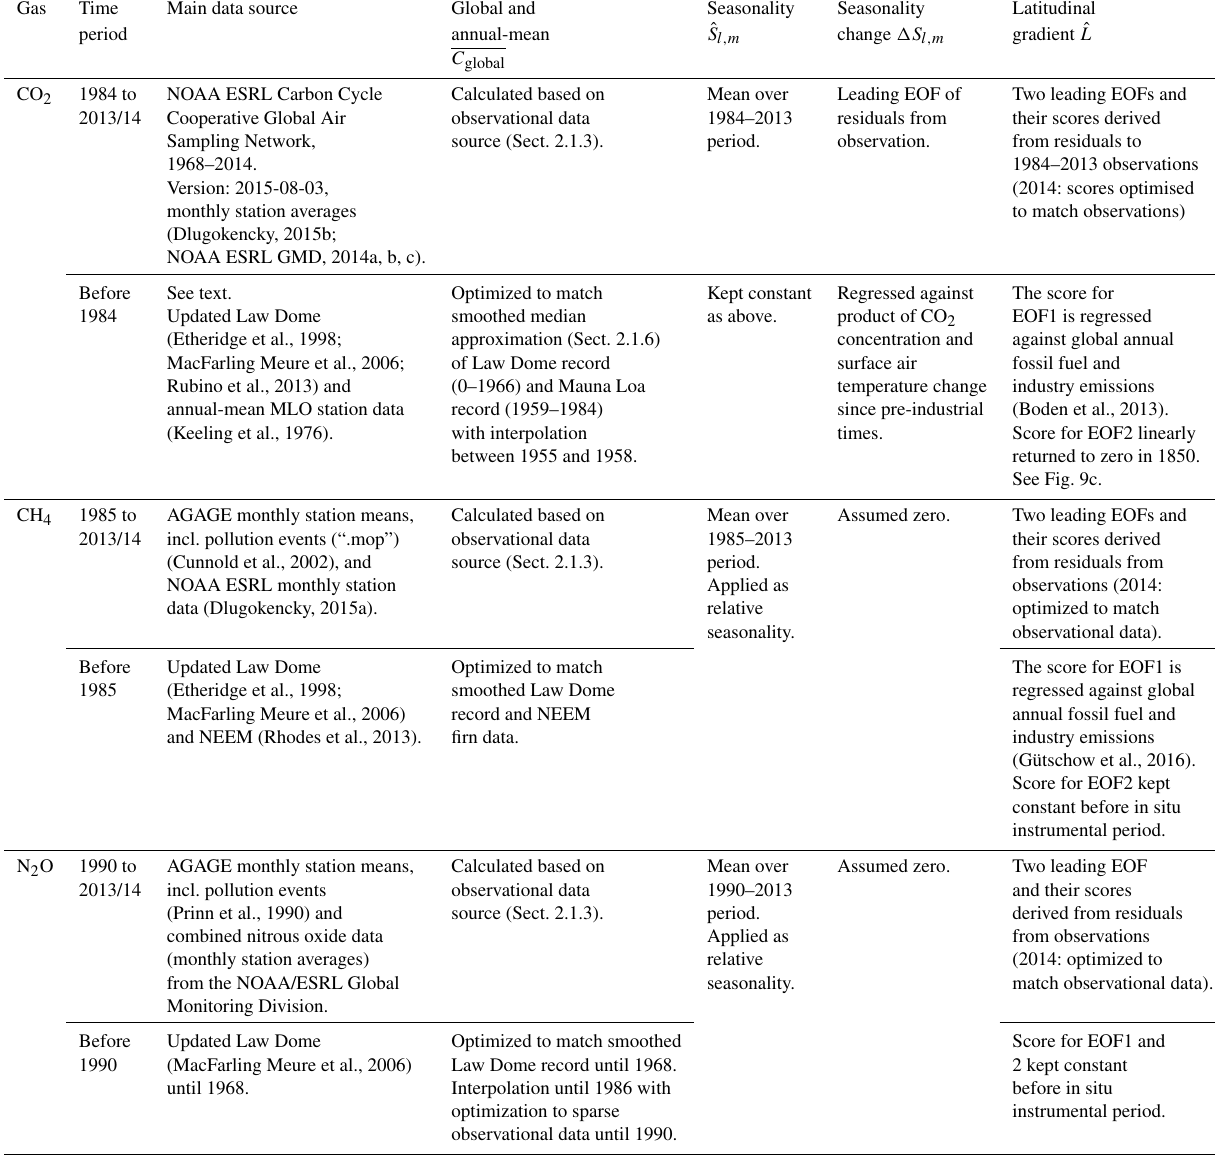
Table 1. Derivation and construction of CMIP6 concentration fields for CO 2 , CH 4 and N 2 O, as shown in Fig. 1 and described in Sect.